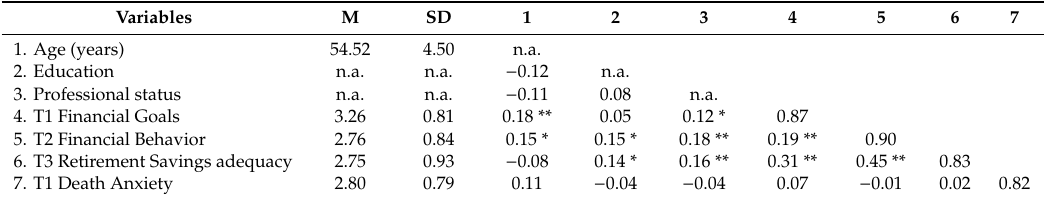
Table 1. Mean values, standard deviations, Cronbach alphas (on the diagonal), and correlations between study variables (N =